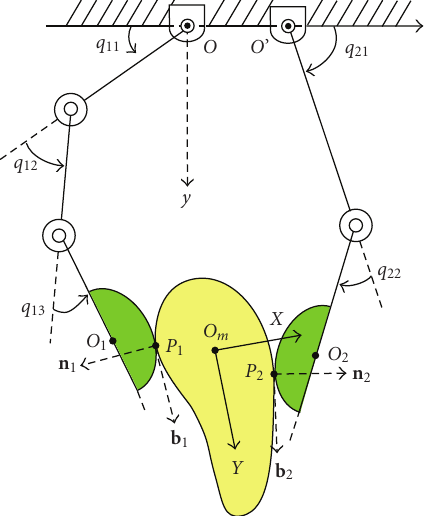
Figure 1: A pair of two-dimensional robot fingers with a curved fingertip makes rolling contact with a rigid object with a curved